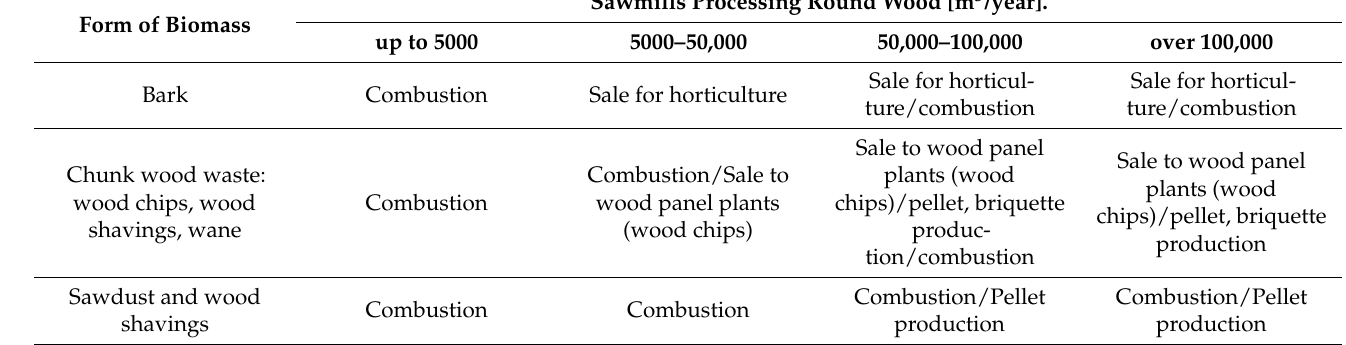
Table 5. Use of generated wood biomass.